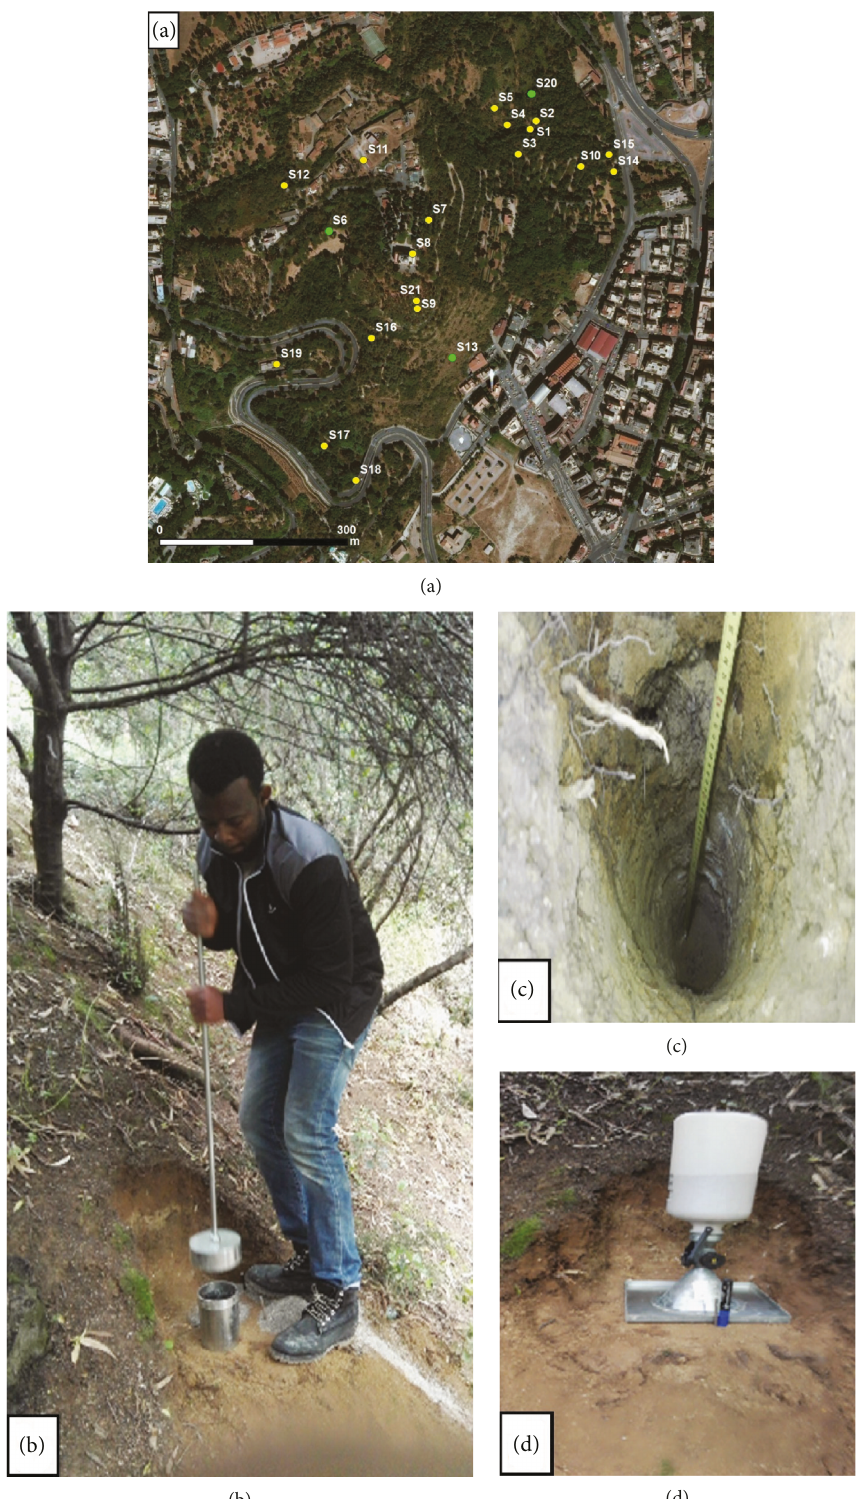
Figure 3: (a) Locations of the 21 samples collected on Monte Mario; (b) the sampling stage; (c) borehole for the evaluation of the soil cover thickness. The location of the three boreholes is marked in green in Figure (a); (d) test for density and unit weight of soil in place by the sand cone